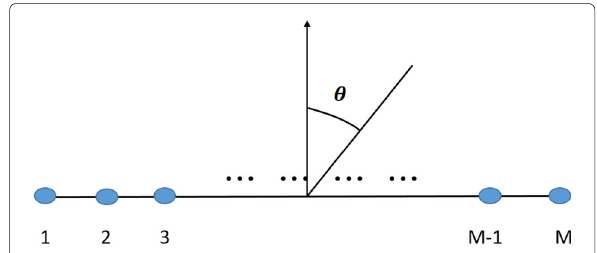
Fig. 2 A uniform linear array with signal direction angle θ